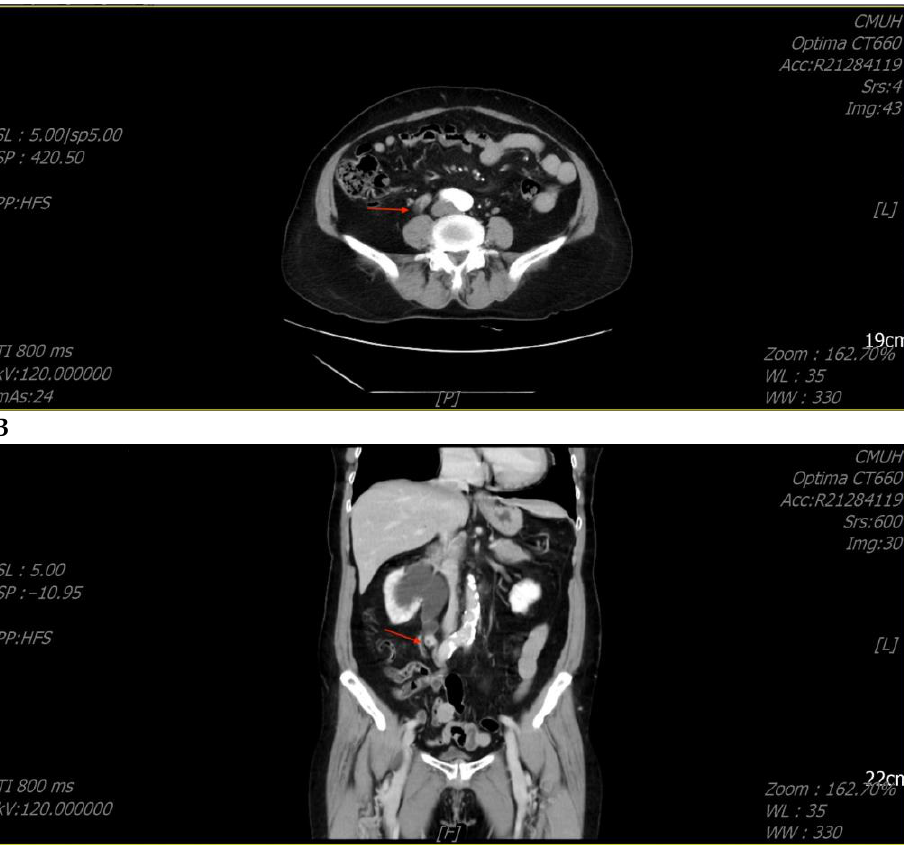
Figure 3. Computed tomography of the abdomen revealed a tumor (arrowhead) in the right upper ureter with proximal dilatation. ( A ) Coronary view; ( B ) Sagittal